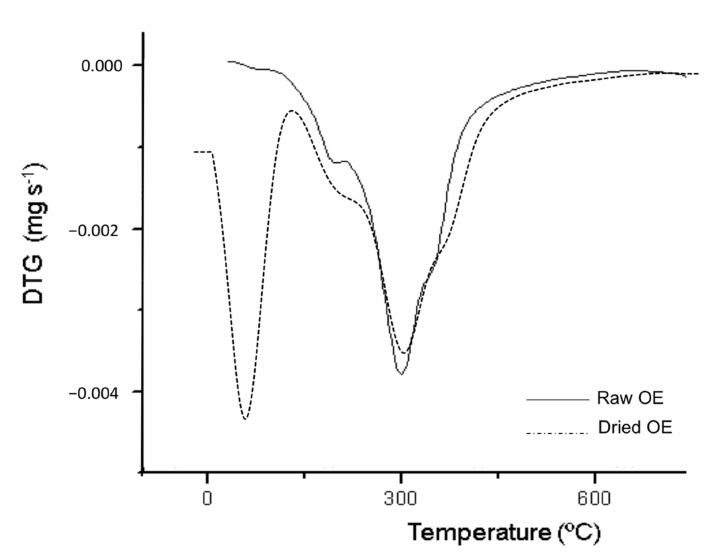
Figure 4. Derivative thermogravimetric (DTG) curves obtained for raw and dried OE.